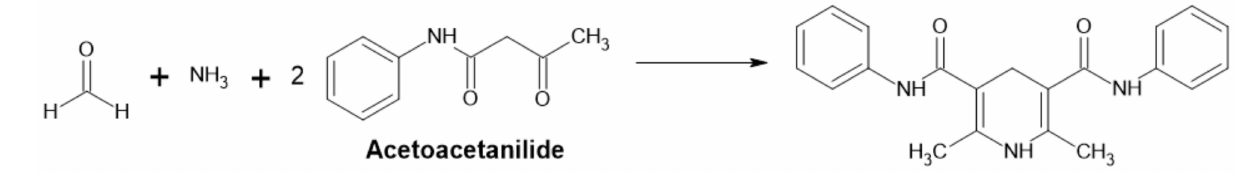
Figure 13. Detection of aldehyde by acetylacetanilide.